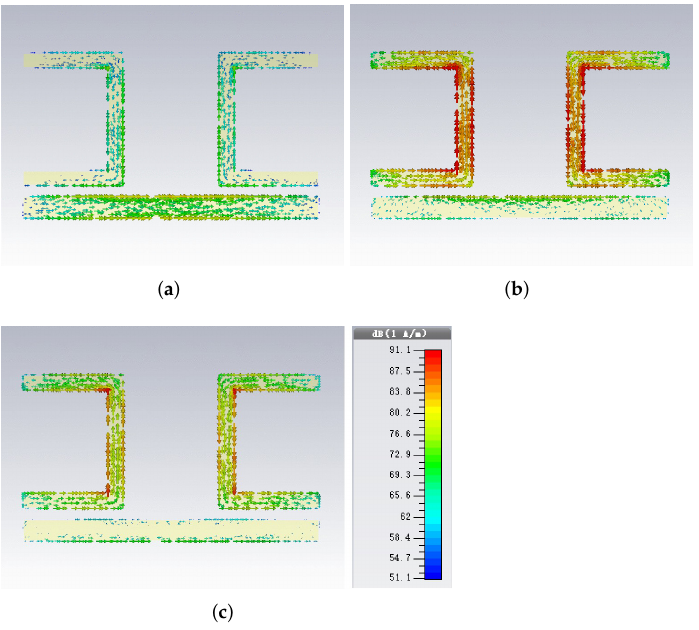
Figure 5. The surface current of CWSRRs at ( a ) 0.576 THz, ( b ) 0.61 THz, and ( c ) 0.622 THz. Furthermore, we investigated the sensitivity of the two resonance dips. The analyte’s thickness was set at 4 µ m. We varied the permittivity from ε = 1 to ε = 4 with an incremental step of 1. The total electric capacity of the sensor was C = C 1 + C 2 + C 3 + C 4 [40], C 1 was the electric capacity of the substrate, C 2 was the electric capacity between the substrate and the sensor structure, C 3 was the electric capacity of the sensor structure, and C 4 was the electric capacity between sensor structure and the analyte. As we know, the electric capacity C = ε S / d . Thus, C 4 increased with the permittivity of the analyte that covered the sensor. The two resonance dips shifted to a low frequency as the permittivity of the analyte increased, as shown in Figure 6.